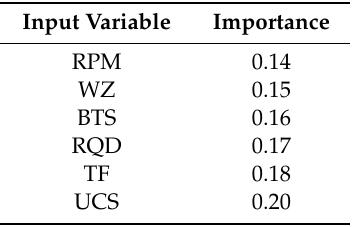
Table 6. Importance of input variables in the developed KNN model.